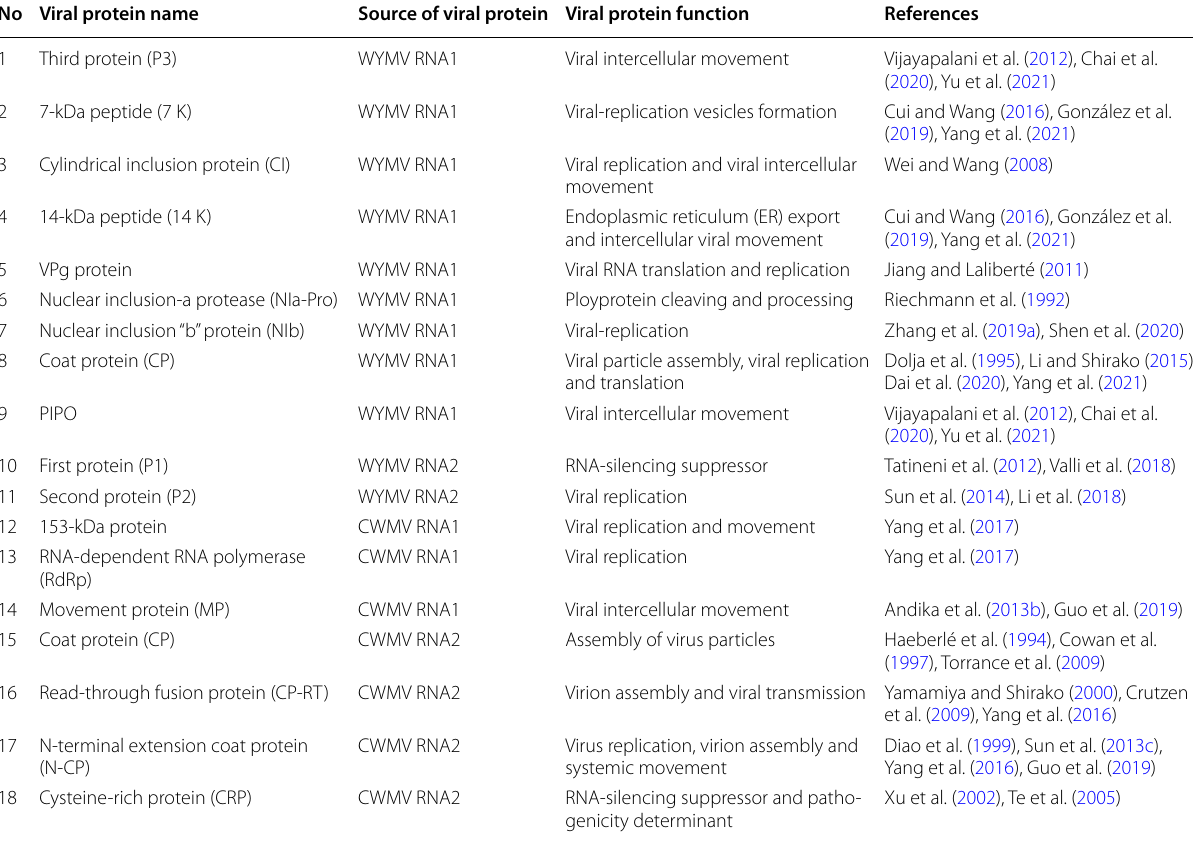
Table 2 The potential function of the proteins encoded by CWMV and